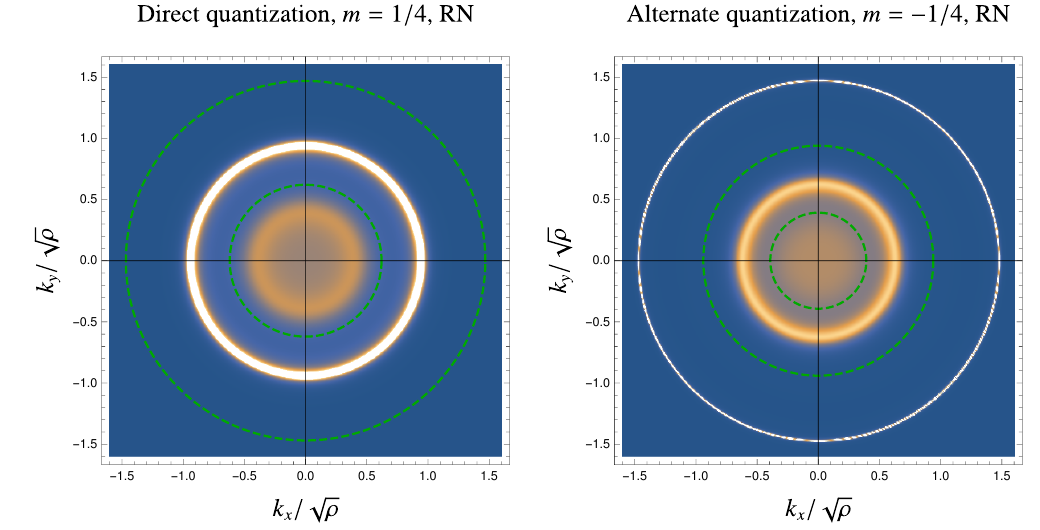
p Figure 2 . The fermionic spectral density at near the Fermi level ( ! = 0 : 01 (cid:26) ) in the isotropic Reissner Nordstr(cid:127)om background (3.1) for m = 1 = 4 ; q = 1. The density plot shows the distribution of the spectral density in momentum plane k x , k y for the direct (left panel) and alternative (right panel) quantization picture. The circular Fermi surfaces are seen, which are expected for the isotropic background. In both cases there are two nested FS with di(cid:11)erent lifetime of the excitation. The positions of the FS in the other quantization picture are shown with the dashed lines on each p panel, which makes apparent their alternating structure. T= (cid:26) = 0 : 01, (cid:22) 2 =(cid:26) (cid:25) 3 : 329. the Green’s function is indeed to study the peaks in its alternatively quantized